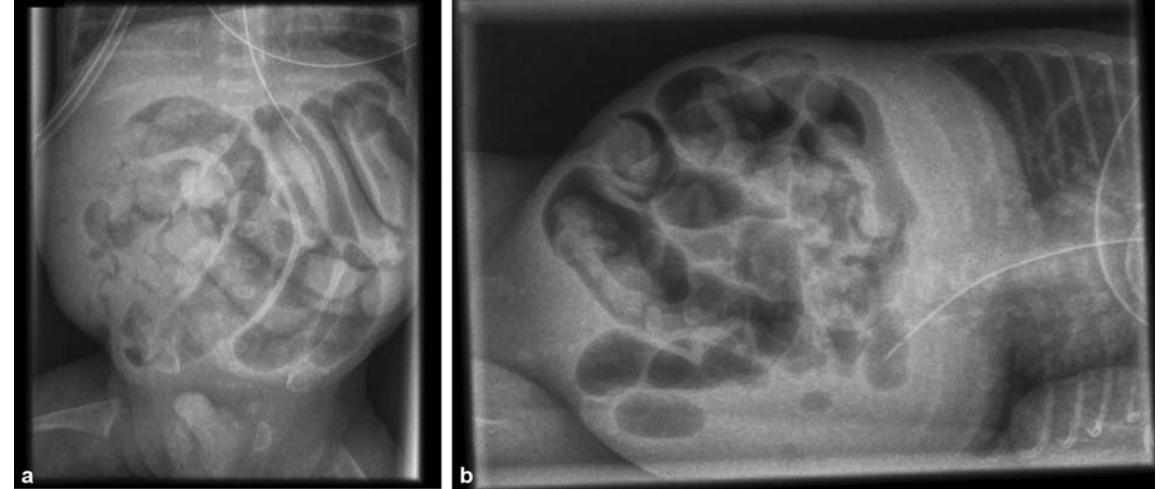
Fig. 1 X-rays on day 14 of life in supine ( a ) and left lateral ( b ) positions revealed distended gas- and meconium- fi lled small intestinal loops; no intra-abdominal free air, air- fl uid levels, or pneumatosis was